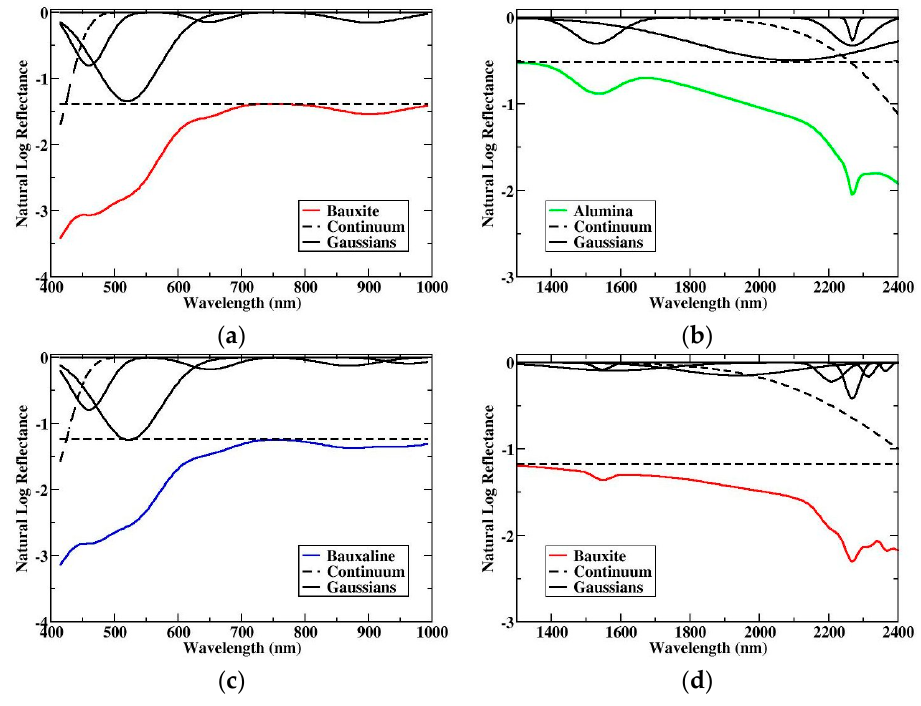
Figure 4. Results of automatized Gaussian model (AGM) deconvolution for representative image spectra. Left: visible and near-infrared (VNIR) ( a ) bauxite and ( c ) bauxaline ® . Right: short-wavelength infrared (SWIR) ( c ) alumina and ( d ) bauxite.